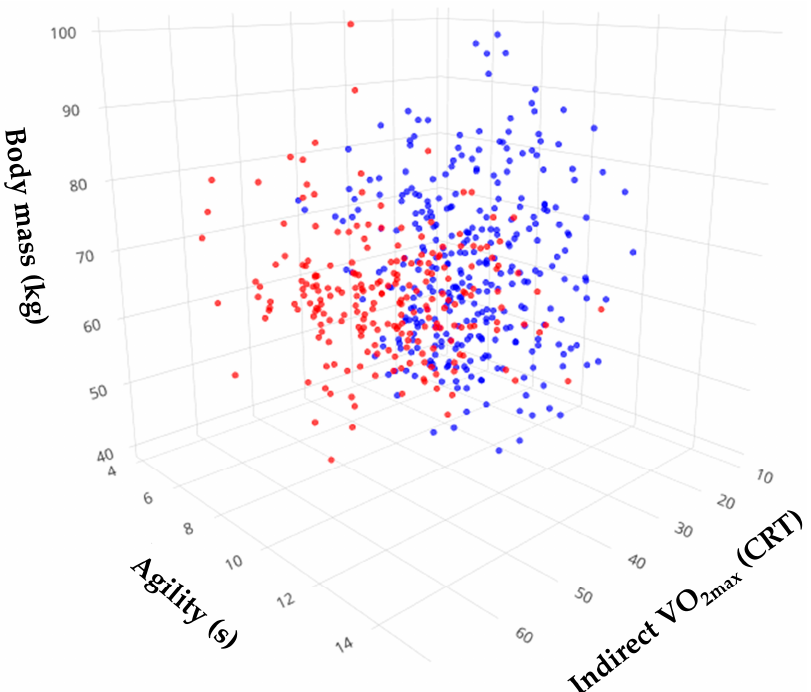
Figure 3. Multidimensional 3D plot of pre-defined variables. The arrangement of clusters within a 3D structure enables to identify of the significant variables that contribute the most to data variation by the natural generation of subspaces.